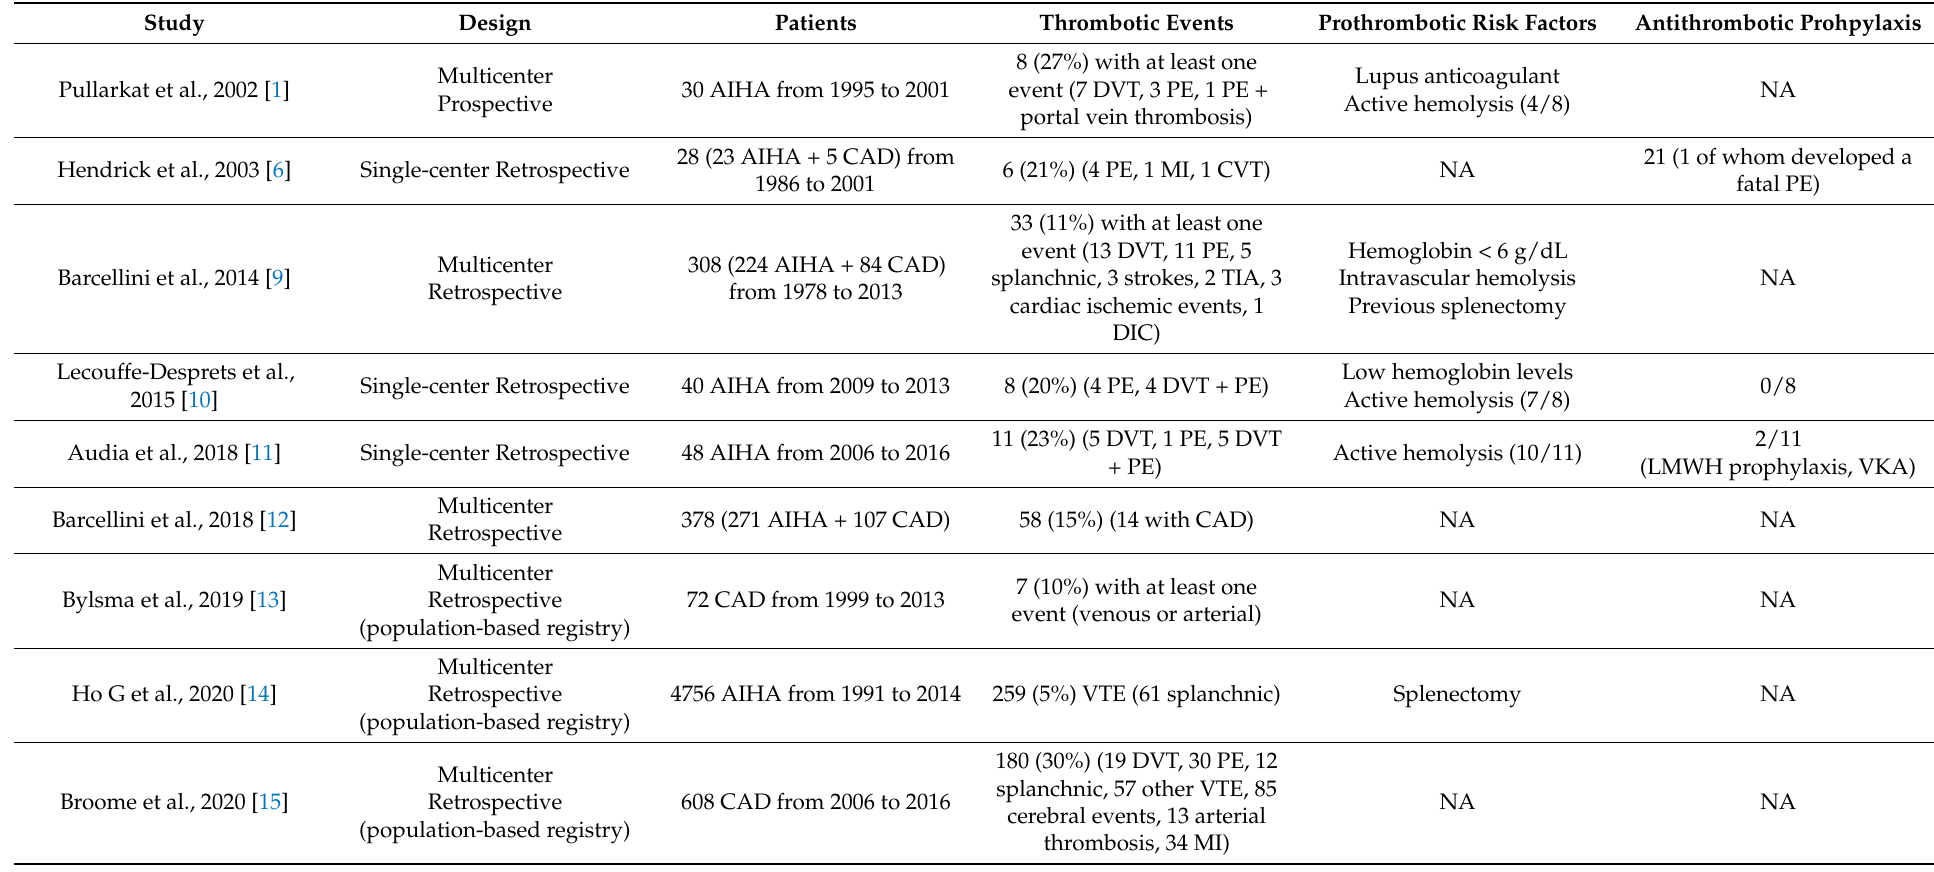
Table 1. Most relevant studies on thrombotic risk in AIHA, CAD and PNH. Where possible, the site of thrombosis and the use of antithrombotic prophylaxis have been reported as well. AIHA, autoimmune hemolytic anemia; CAD, cold agglutinin disease; PNH, paroxysmal nocturnal hemoglobinuria; DVT, deep vein thrombosis; PE, pulmonary embolism; NA, not available; MI, myocardial infarction; CVT, cerebral vein thrombosis; TIA, transient ischemic attack; DIC, disseminated intravascular coagulation; LMWH, low molecular weight heparin; VKA, vitamin K antagonists; VTE, venous